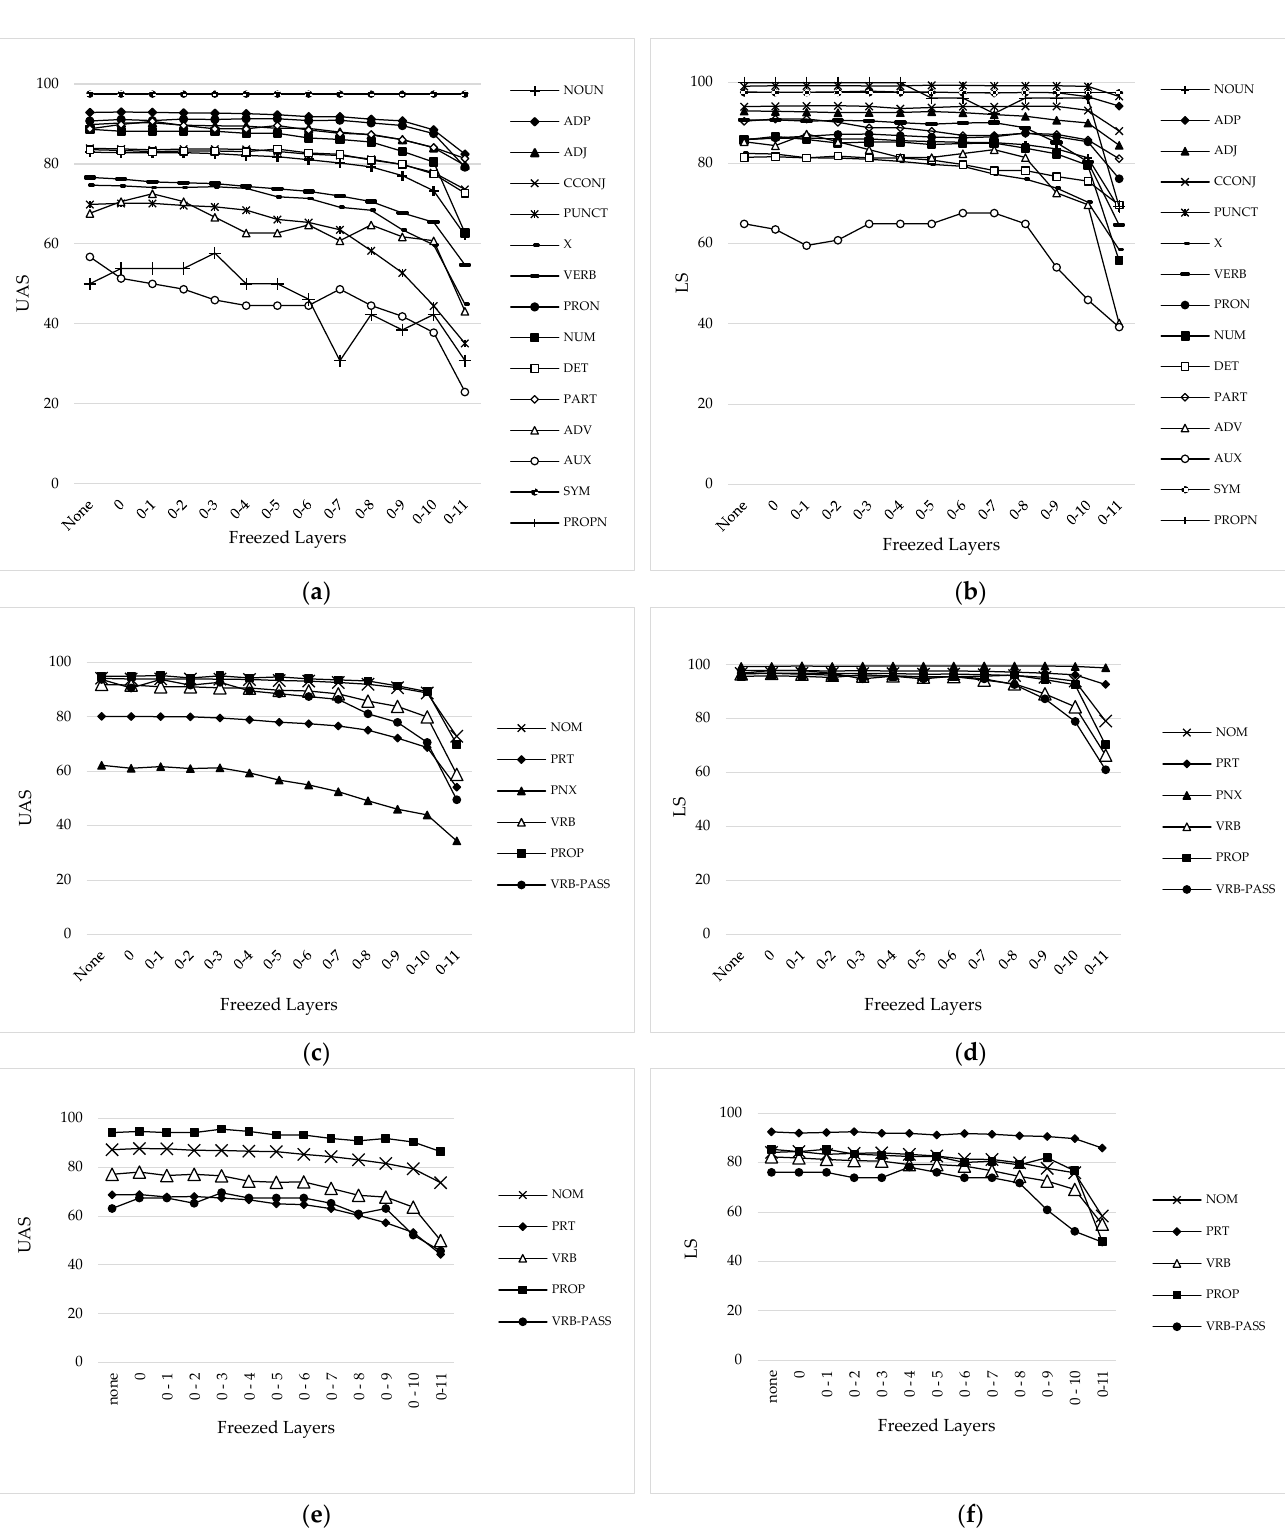
Figure 5. UAS and LS over POS tags and dependency relations in each test dataset freezing an increasing number of layers during fine-tuning. ( a ) PADT UAS. ( b ) PADT LS. ( c ) CATiB UAS. ( d ) CATiB LS. ( e ) ArPoT UAS. ( f ) ArPoT LS.